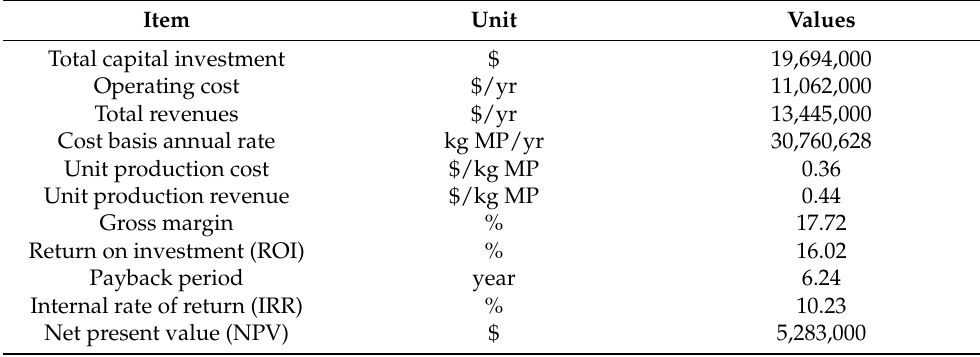
Table 12. Summary of economics